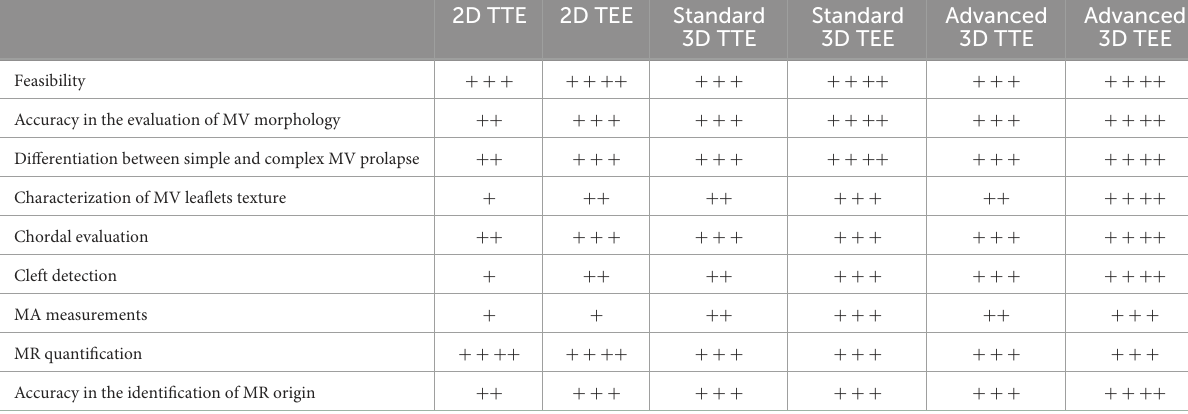
TABLE 1 Incremental role of 3D echocardiography in the evaluation of mitral valve prolapse.